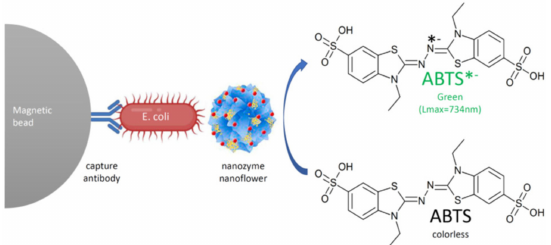
Figure 8. Colorimetric reaction of the peroxidase mimicked by the nanozyme nanoflowers of hemin and concanavalin A showing the colorimetric conversion of 2,2 (cid:48) -azino-bis (3-ethylbenzthiazoline-6- sulfonic acid) from colorless to green as the detection